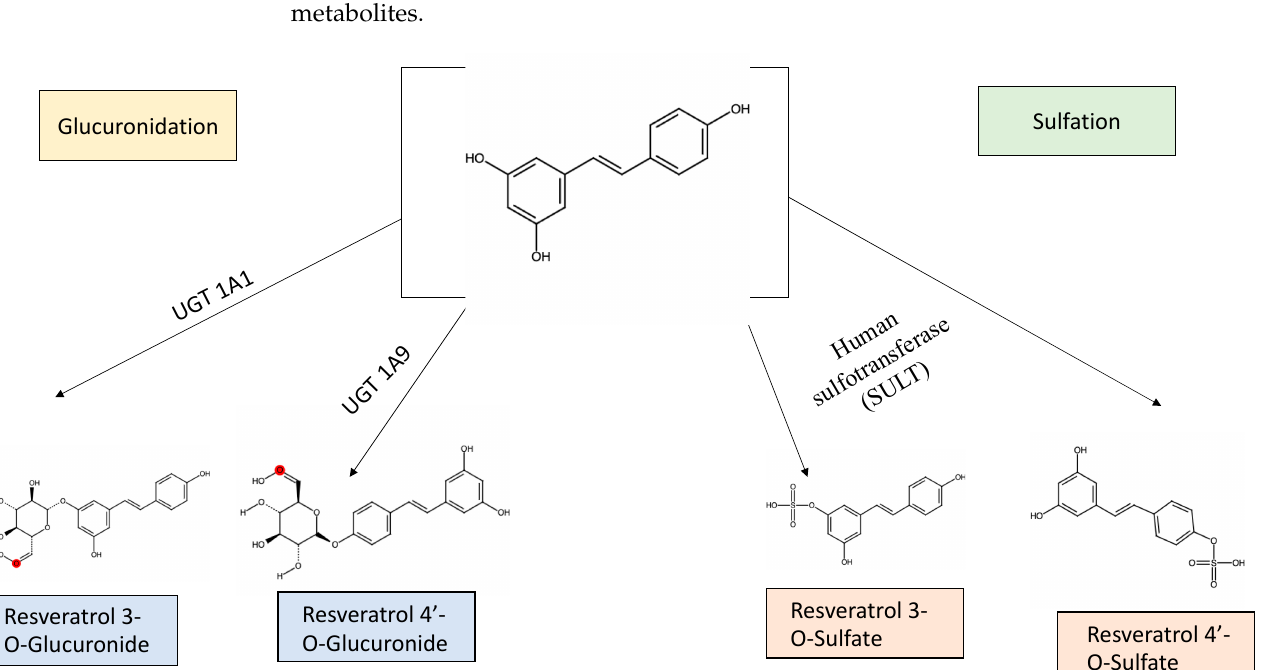
Figure 2. Representation of the metabolism of Resveratrol along with its main metabolites.